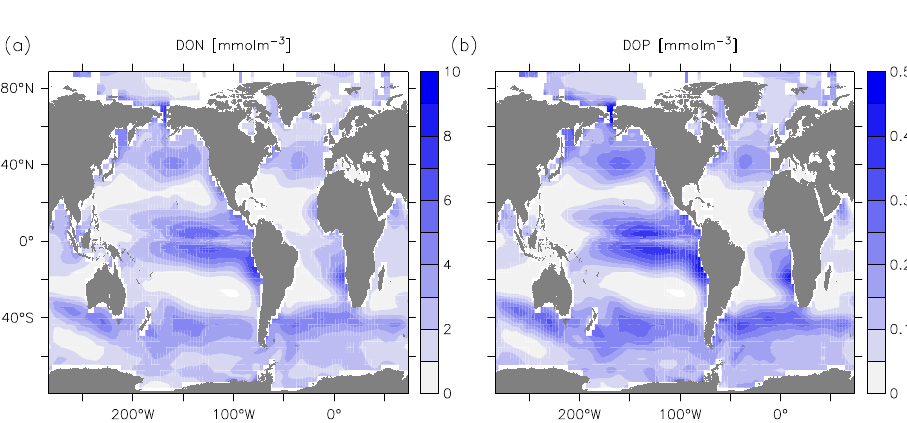
Fig. 8. Average upper ocean (0–100m) concentrations of (a) DON and (b) DOP in the DOM simulation. Figure shows averages over 150 model